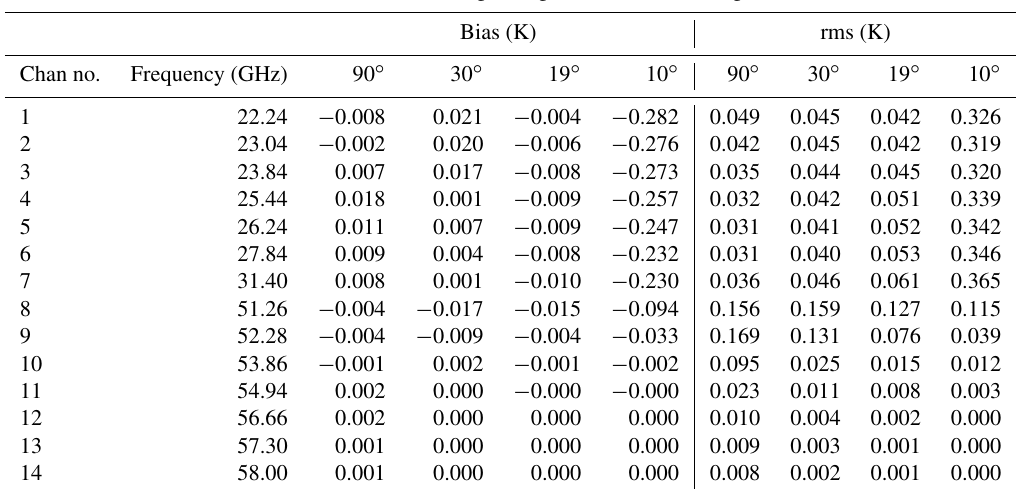
Table 2. Statistics for the comparison between RTTOV-gb and the line-by-line model R98 (Rosenkranz, 1998) with the best RTTOV training configuration and the independent profile set (R98 minus RTTOV-gb). HATPRO channel number (Chan no.), the channel central frequency, bias, and rms at elevation angles 90, 30, 19, and 10 ◦ are reported. Training configuration: elevation angles from 90 to 16